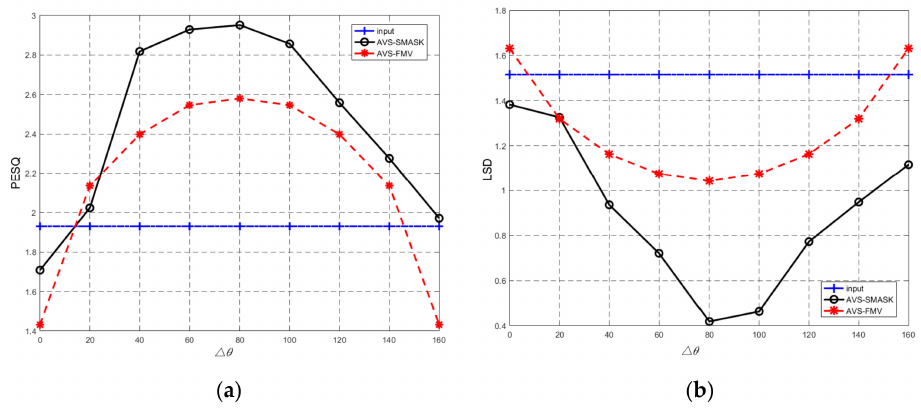
Figure 7. (Experiment 2) The performance versus ∆ θ . ( a ) PESQ results and ( b ) LSD results (Case 2: θ s of the target speaker changes from 0 ◦ to 160 ◦ ).